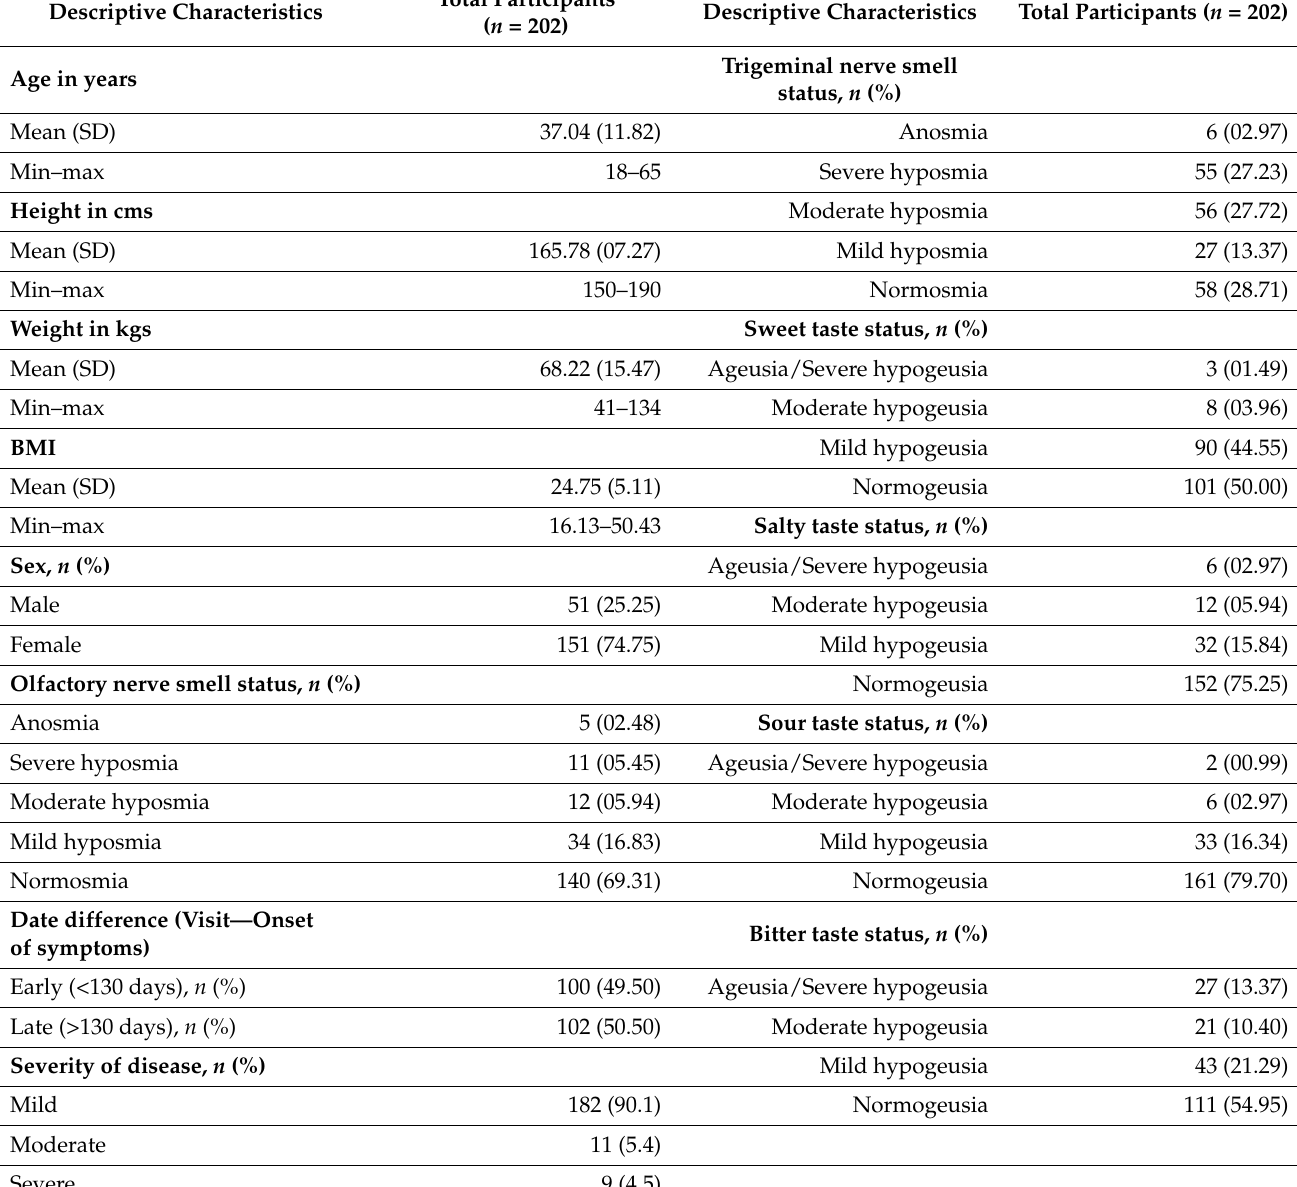
Table 2. Detailed representation of demographic